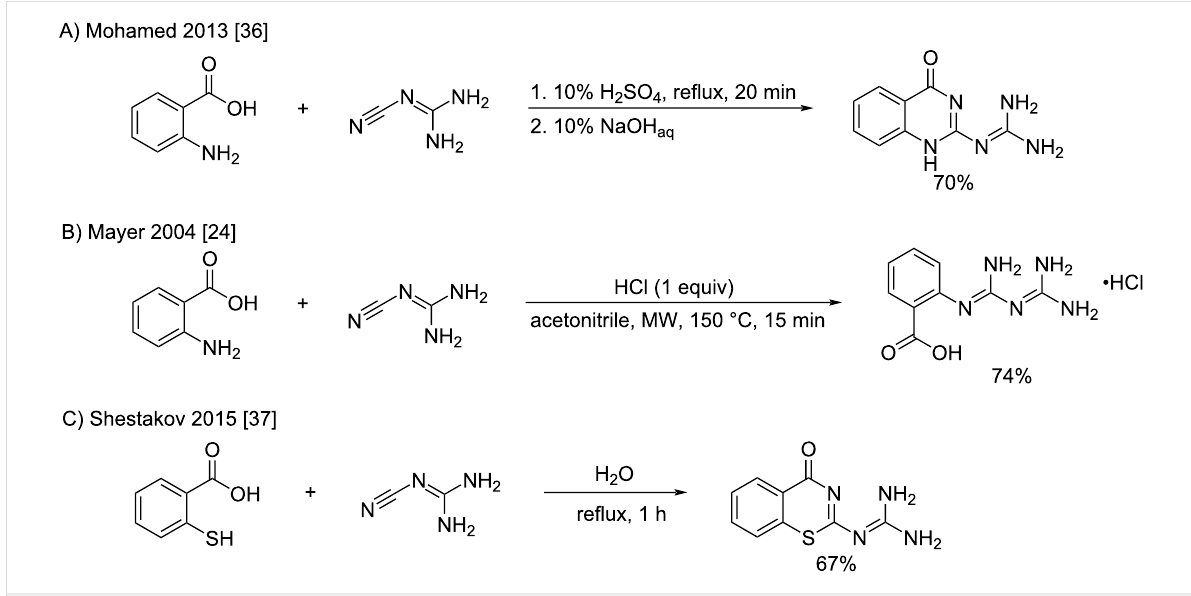
nucleophilic enough to undergo the cyclocondensation toward the desired benzothiazinone in a 67% yield after 1 h refluxing in water, without requiring acidic activation of the cyanoguani- dine (Scheme 13C)